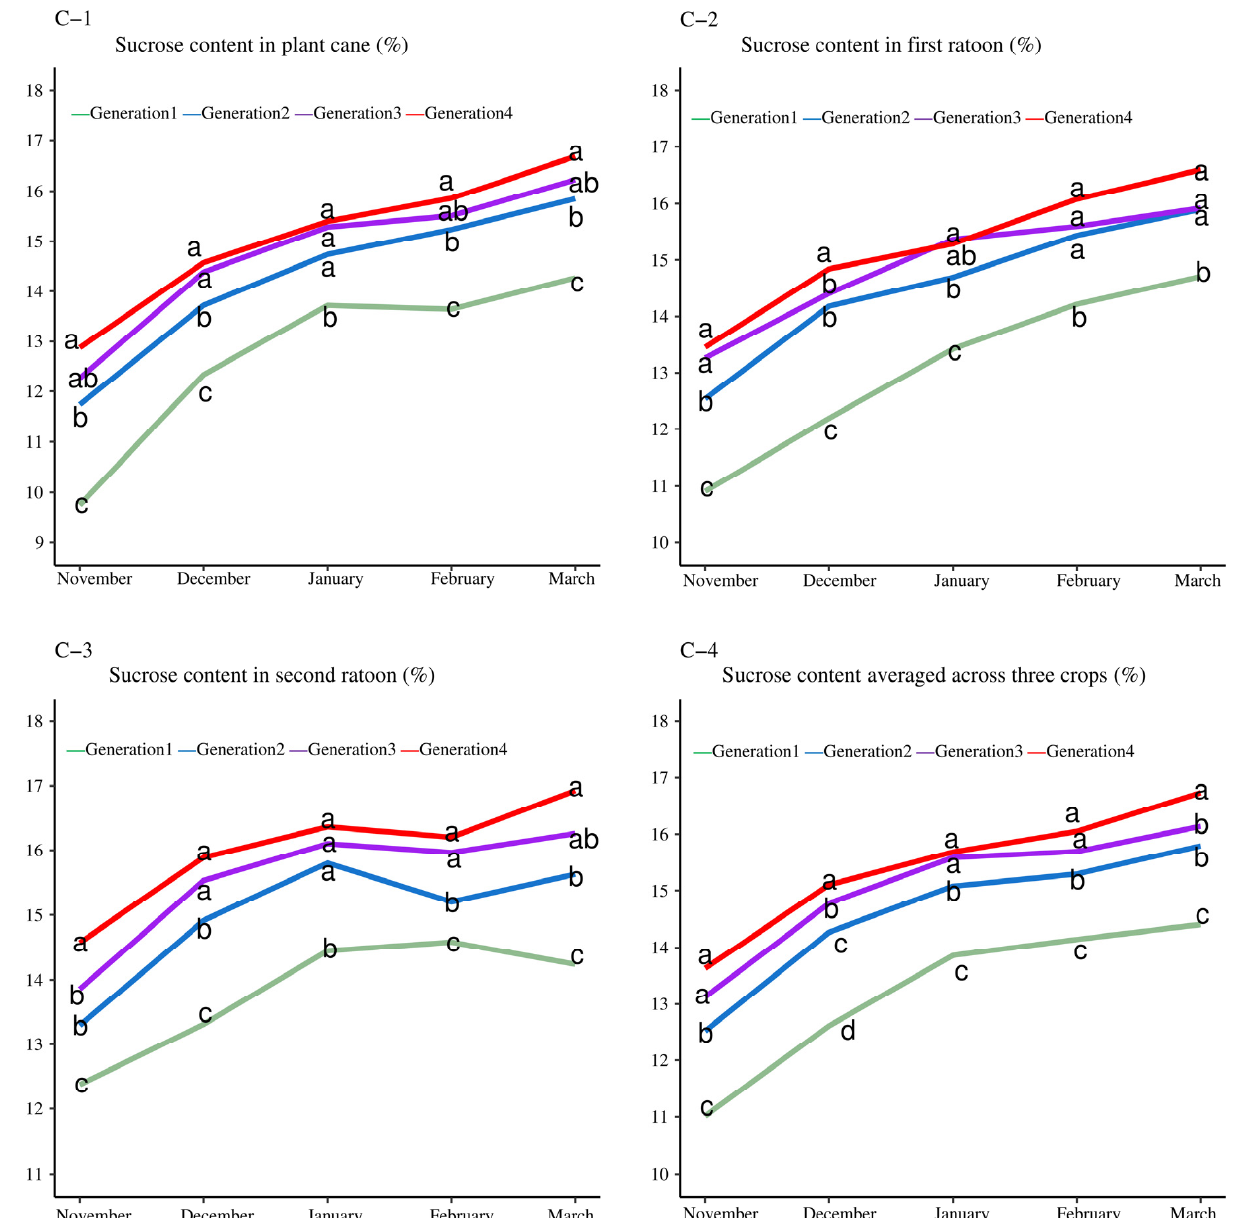
Figure 3. Analysis of the improvements in sucrose content in four generations of sugarcane varieties in China. Monthly differences (November to March) of the four generations for planted cane ( C-1 ), the first ratoon ( C-2 ), the second ratoon ( C-3 ), and the average content across all three crops. ( C-4 ). a, b, c, d, p < 0.05, determined by the LSD test; the LSD test was across generations within a